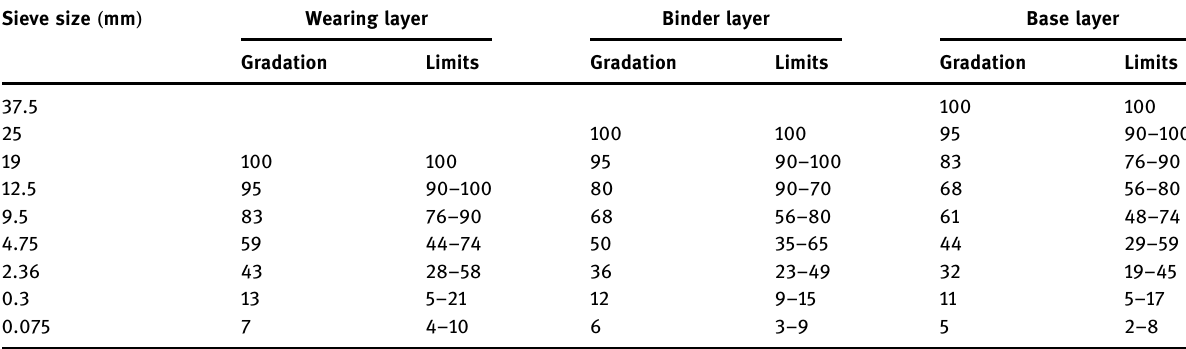
Table 3: Aggregate gradation